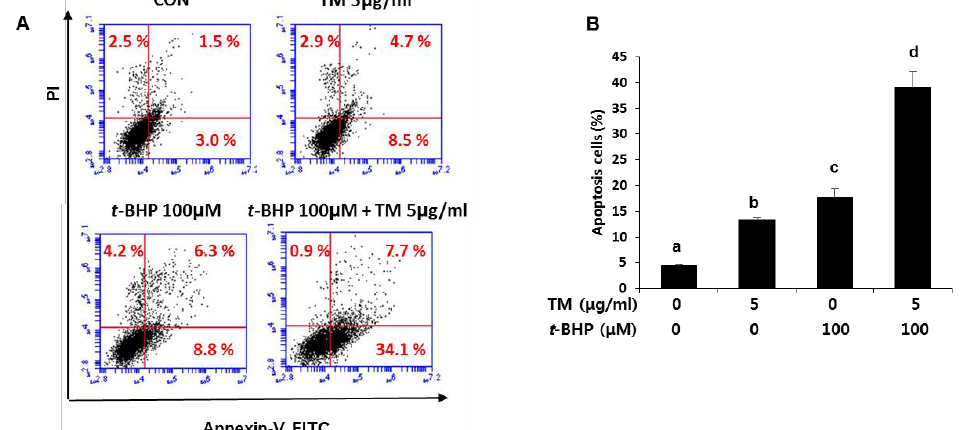
Figure 8. Potentiation of t -BHP-induced apoptotic cell death by the pre-exposure of TM in HepG2 liver cells. ( A ) Cells were exposed to 5 µg of TM for 24 h before treatment with 100 µM of t -BHP for 6 h. Fluorescence-activated cell sorting (FACS) analysis of propidium iodide uptake and annexin V binding in non-permeabilized cells (Lower-left, live cells; Lower-right, early apoptotic cells; upper-right, late apoptotic cells). ( B ) Quantification of apoptotic cells was represented in the three independent experiments. Values with different letters are significantly different from one another (ANOVA followed by Newman-Keuls multiple range test p < 0.05).